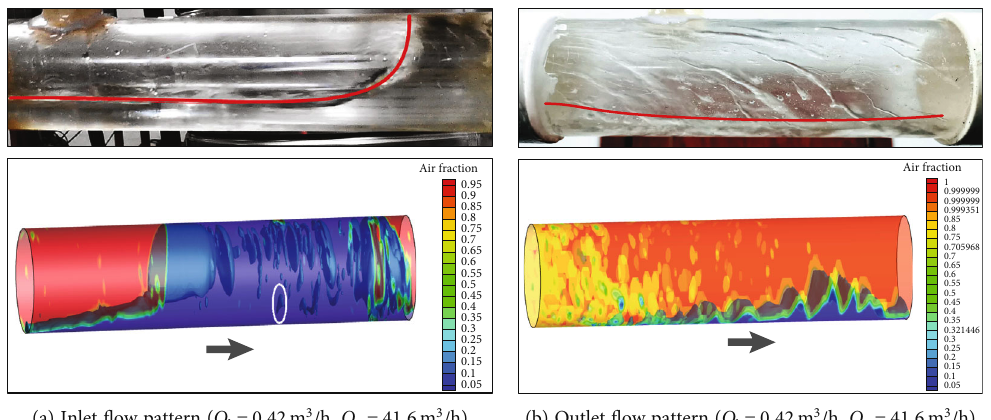
Figure 5: Fluid motion at the inlet and outlet of the experimental setup.